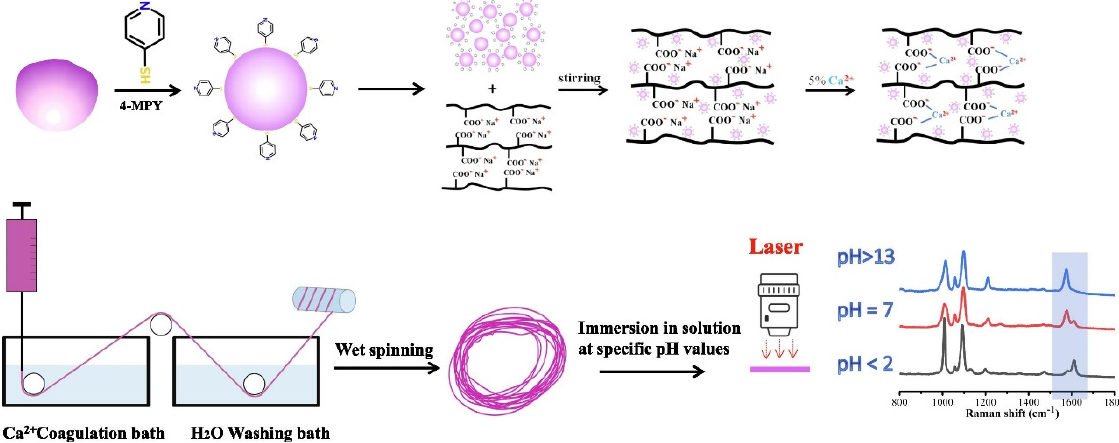
Figure 21. Illustration for the preparation of AuNPs@4-MPY/Ca-ALG composite fibber and pH sensing based on SERS. Reproduced with permission from [125]. Copyright 2022 Elsevier B.V.